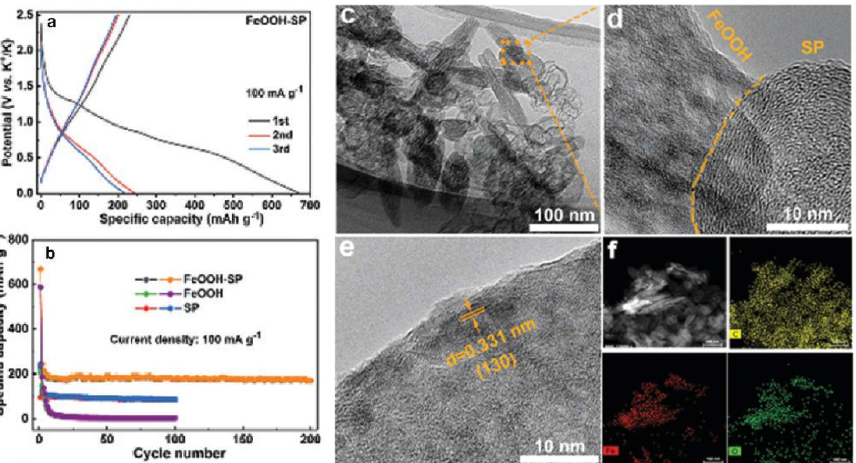
Figure 10. ( a ) Galvanostatic discharge/charge voltage profiles for the first three cycles of the FeOOH- SP composite cycled in a K half-cell at 100 mA g − 1 between 0.01 V and 2.50 V. ( b ) Cycle performances and capacity retention of the same K half-cell with FeOOH-SP compared to those of the individual β -FeOOH and SP. ( c ) Low-magnification transmission electron microscopy (TEM) image of FeOOH- SP composite and ( d ) magnified detail highlighting respective β -FeOOH and SP morphologies and textures. ( e ) HRTEM showing characteristic lattice fringes for β -FeOOH. ( f ) Elemental mapping showing individual distributions of carbon (yellow), iron (red) and oxygen (green) in the FeOOH-SP composite. Reprinted with permission from Ref. [77]. Copyright 2022 the Royal Society of